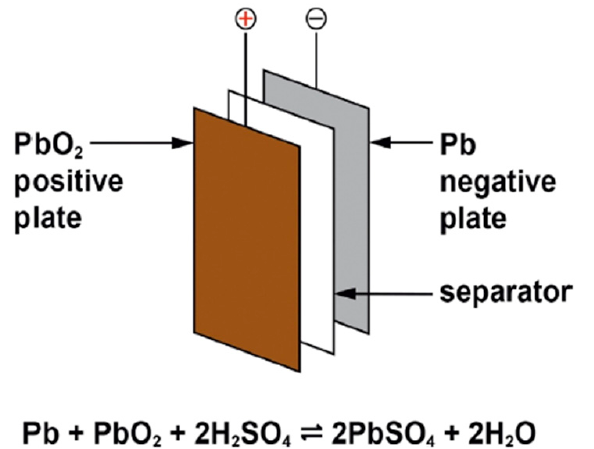
Figure 6. Chemistry of lead–acid battery.